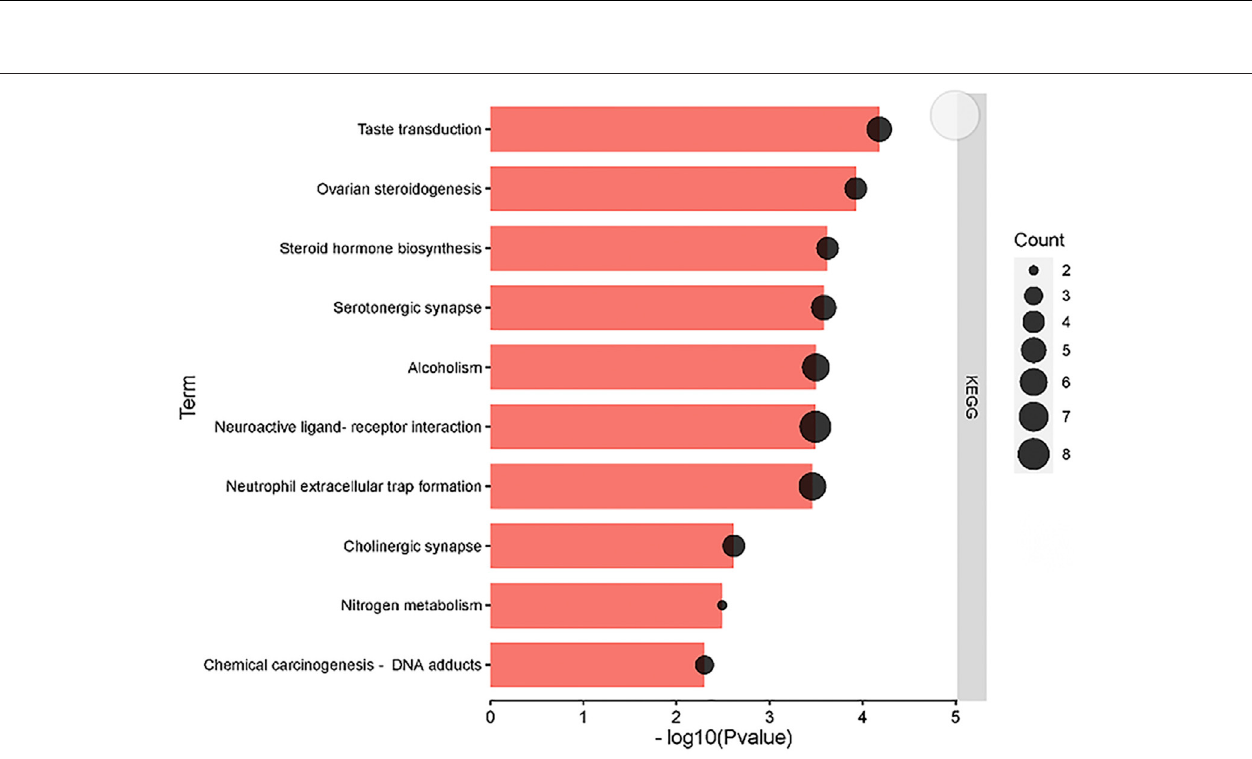
Frontiers in Cell and Developmental Biology |